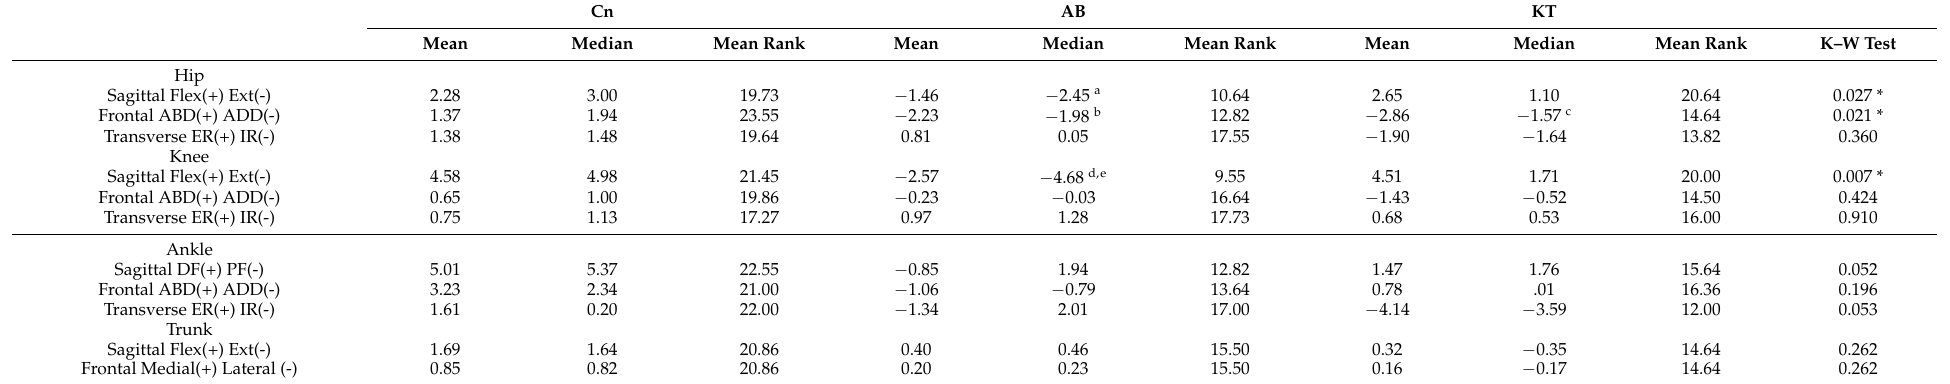
Table 2. Kruskal–Wallis and post hoc test results for fatigue-induced changes in the range of the joint angle in lateral drop landing tasks performed by the three